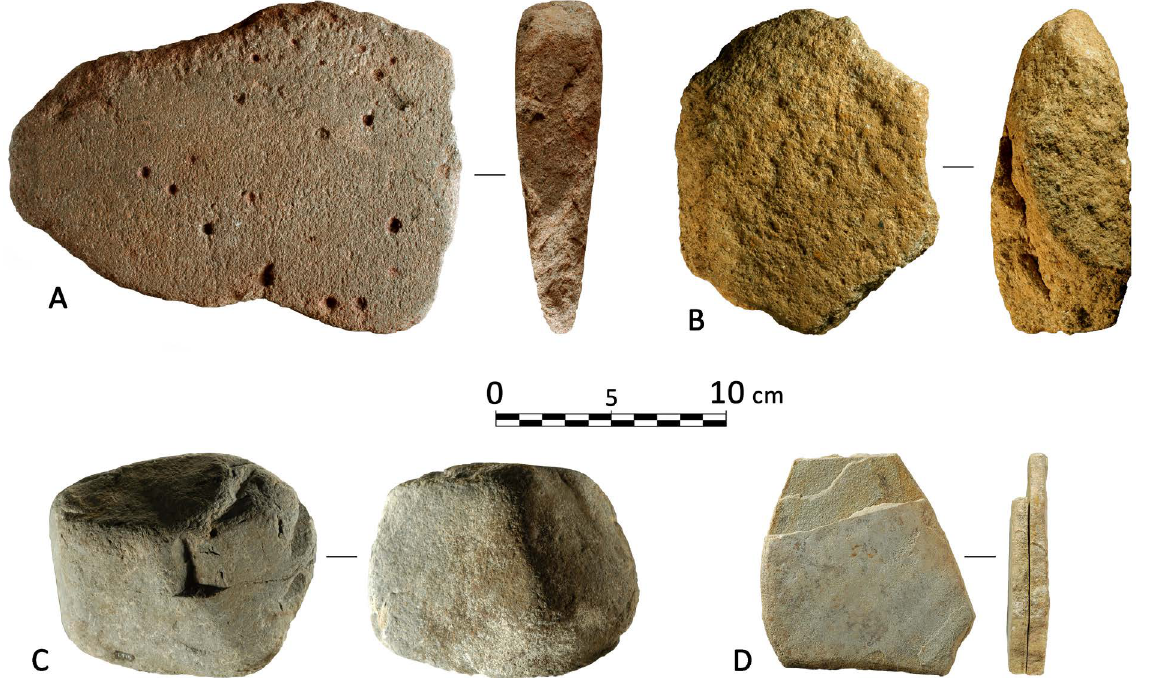
Figure 10. Grinding and abrasion tools from Grotta Monaca: A. Sub-quadrangular quern with triangular cross- section; B. Sandstone grinder or crusher; C. Limestone pebble grinder or crusher; D: Abrading stone or slab used to abrade lithic